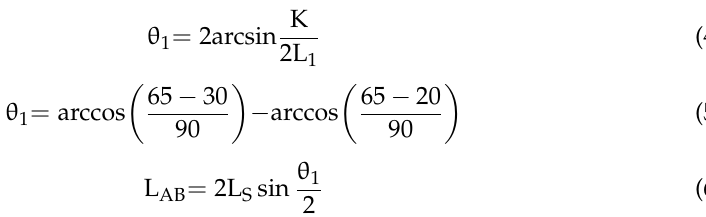
Figure 4. Schematic diagram of pressure plate rotation.